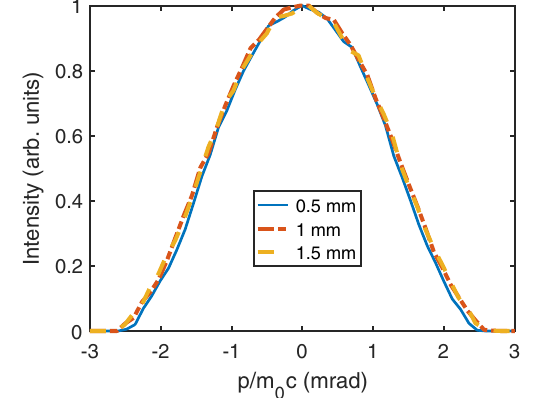
FIG. 12. The measured profiles of transverse momentum with different laser diameters, namely 0.5 mm, 1.0 mm and 1.5 mm.